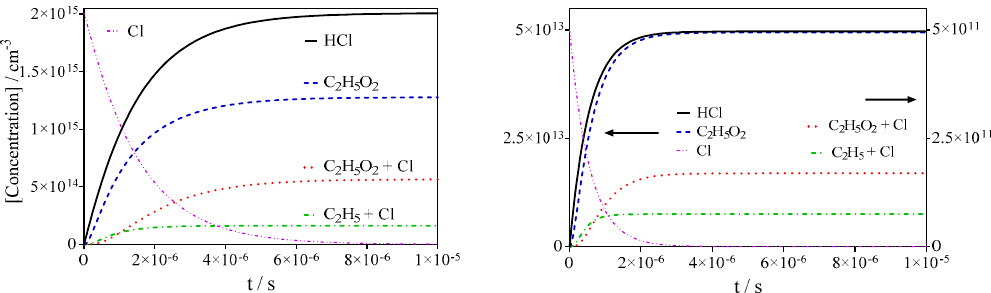
Figure 8. Simulation of conversion of Cl-atoms (violet dashed dot) into HCl (black) and C 2 H 5 O 2 (blue dashed): model taken from Melnik et al., completed with the reactions of Cl with C 2 H 5 O 2 ( k = 1.5 × 10 − 10 cm 3 s − 1 ) [41] (red dotted) and C 2 H 5 ( k = 3 × 10 − 10 cm 3 s − 1 ) [42] (green dashed dotted): left graph conditions such as used in Melnik et al. [17], right graph conditions such as used in this work. The products from the reaction of Cl with C 2 H 5 O 2 (red) and with C 2 H 5 (green) are zoomed in the right graph by a factor of 100 (right y -axis applies).